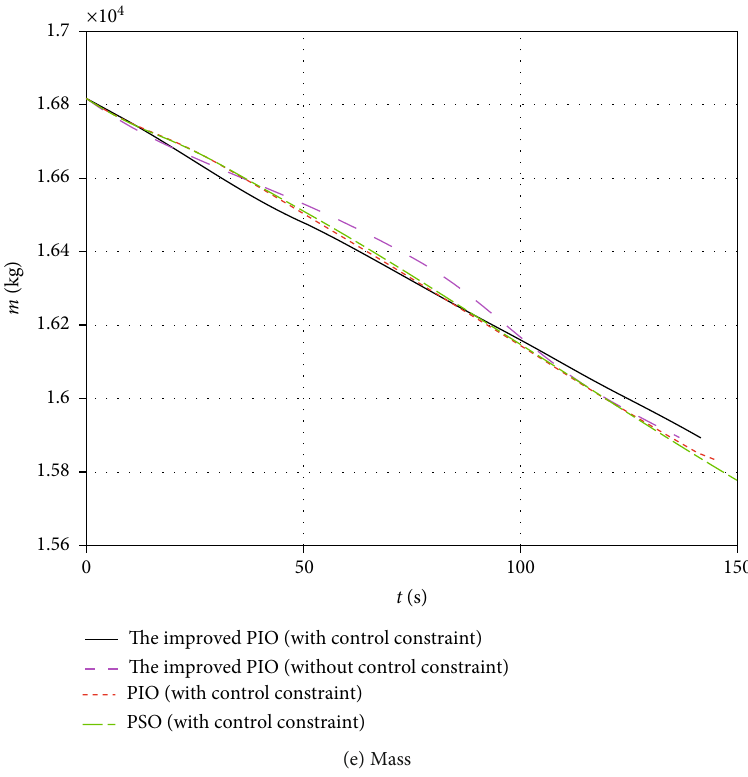
Figure 5: State variables of optimal ascent